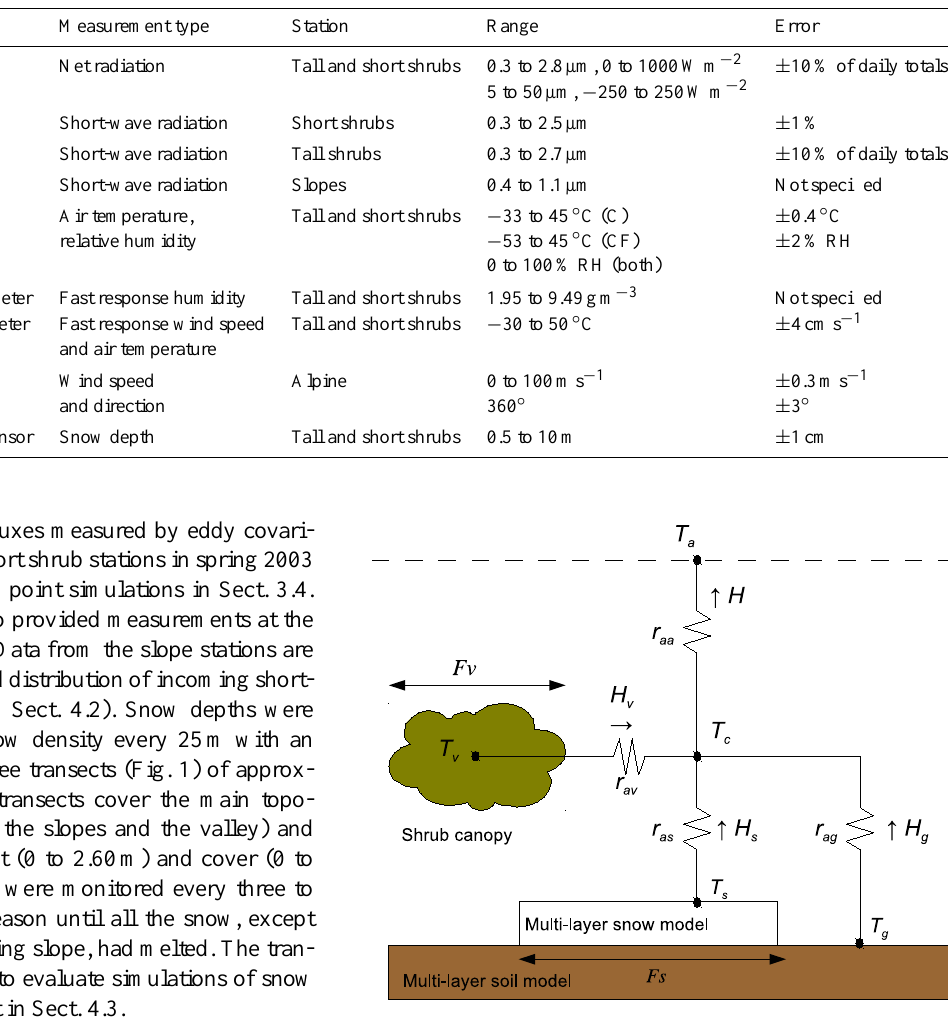
Figure 2. Structure of 3SOM with reference to the heat exchanges and the resistance